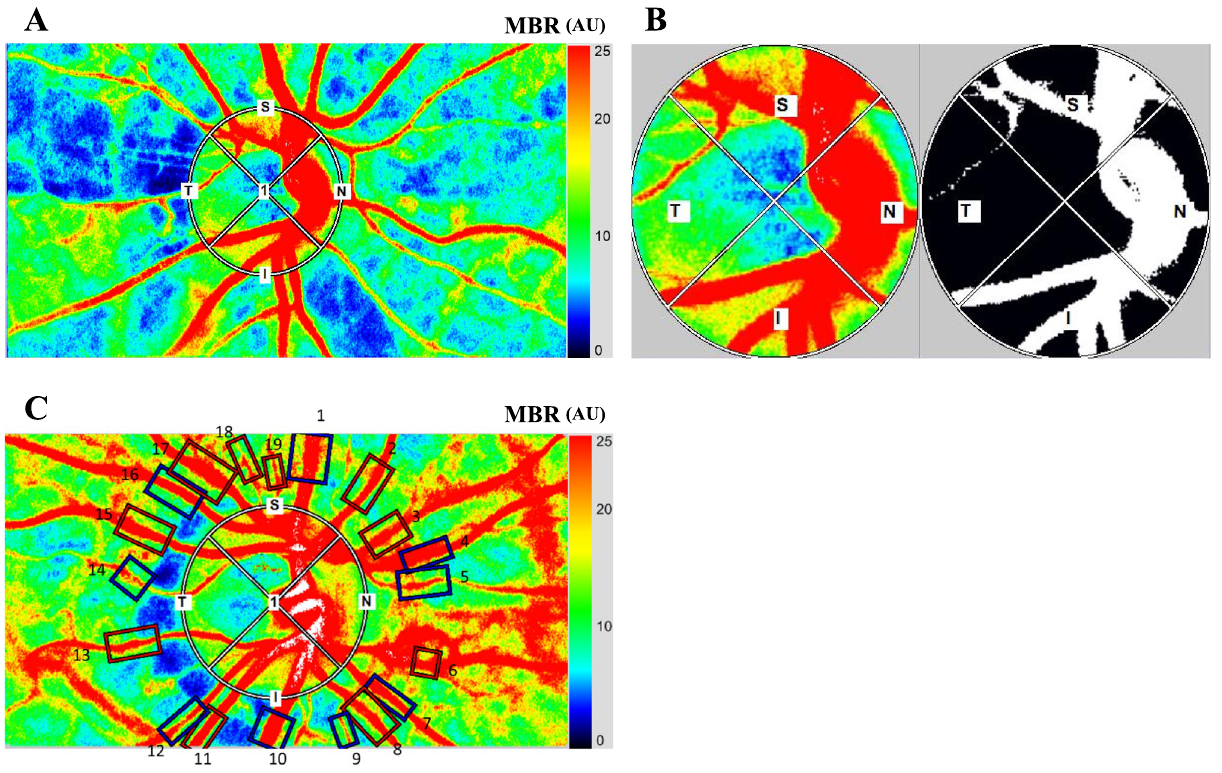
Figure 1. A circular marker was set surrounding the optic nerve head (ONH) to measure the mean blur rate (MBR) ( A ). The “vessel extraction’’ function of the software then identified the vessel and tissue areas on the ONH so that the MBR could be assessed separately as the vessel areas (MBR-vessel) and the tissue areas (MBR- tissue) ( B ). The rectangular areas (1 to 19) were set semi-automatically to the vessels around the optic nerve head concentrically and the total retinal flow index (TRFI) was calculated ( C (Fig. 1B). To evaluate the retinal circulation, the relative flow volume (RFV) index and the total retinal flow index (TRFI) were calculated. The calculation of the RFV has been described in detail 36 . The TRFI represents the total of retinal arterial and venous blood flow volume which was calculated from the total RFV index for all of the major retinal vessels around the ONH semiautomatically. To measure the TRFI, rectangular bands were set around all of the major vessels of the ONH using the built-in image analysis software (Fig. 1C). If there was an error in the placement, we corrected the location of the rectangular band manually. LSFG was performed twice for each time point in all of the eyes. The average MBR values were calculated for each circle or rectangle using the LSFG Analyzer software (v.3.1.59). Adaptive optics (AO) imaging. The rtx1 AO is an adaptive optics device (Imagine Eyes, Orsay, France) 37 , and its principles have been described in detail 38, 39 . We recorded images of the arterioles in Zone B which was located 0.5–1 disc diameter from the optic disc margin. The vascular measurements of this area were made by the software AO which can detect the retinal arteries. We obtained the external diameter (ED), lumen diameter (LD), wall thickness (WT), and wall to lumen ratio (WLR) for the retinal arteries, which were measured by two retinal specialists (YU, TI). Statistical analyses. The value of each parameter is presented by the means ± standard deviations. Com- parisons between groups were made using one-way ANOVA (for continuous variables) and the x 2 test (for categorical variables). One-way ANOVA was followed by a post hoc comparison with Tukey HSD or Games- Howell procedure. Spearman’s rank correlation coefficient tests were used to determine the significance of the correlation coefficients between the variables. Multiple stepwise regression analysis was used to determine the association between blood flow parameters and the other variables. All statistical analyses were performed using